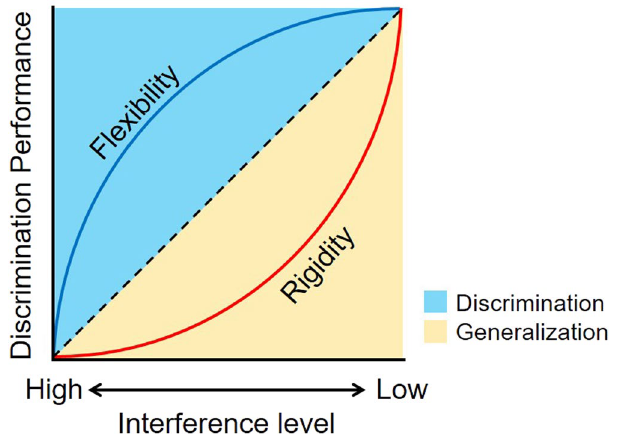
Figure 5. Conceptual model of memory rigidity and flexibility. Memory rigidity is observed with loss of DG function and loss of pattern separation as seen in aging and in loss of neurogenesis and other models of pathology. Conversely, memory flexibility is expected with enhancement of DG function and enhanced pattern